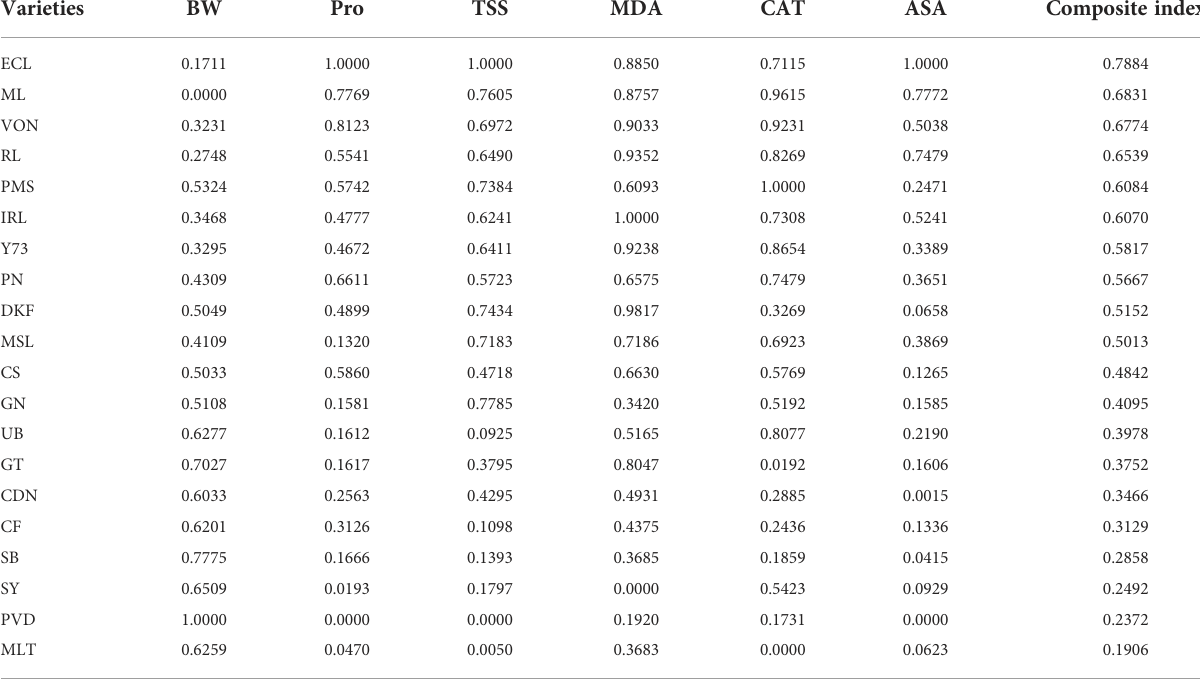
TABLE 7 Subordination values of cold resistance indicators of shoots from different varieties.